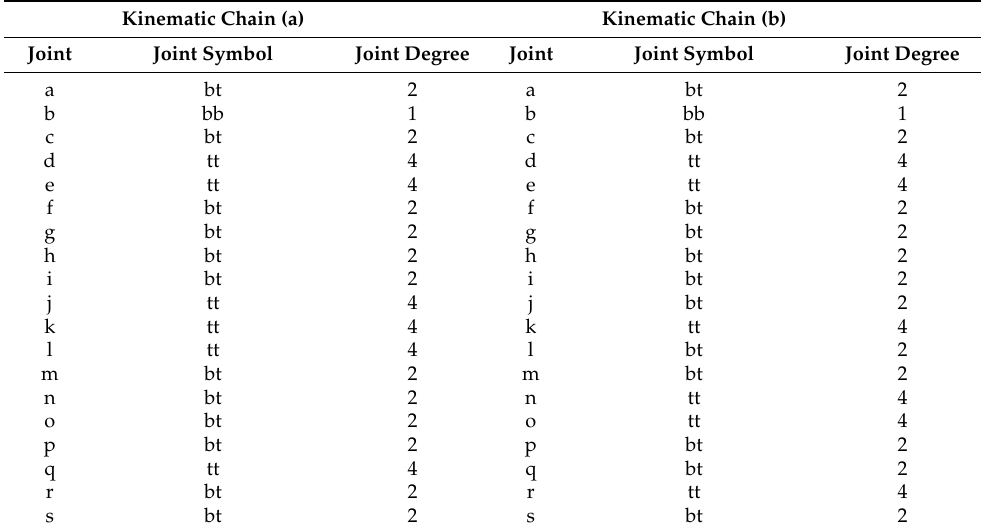
Table 9. Values of Joint degrees for kinematic chains in Figure 13a,b.